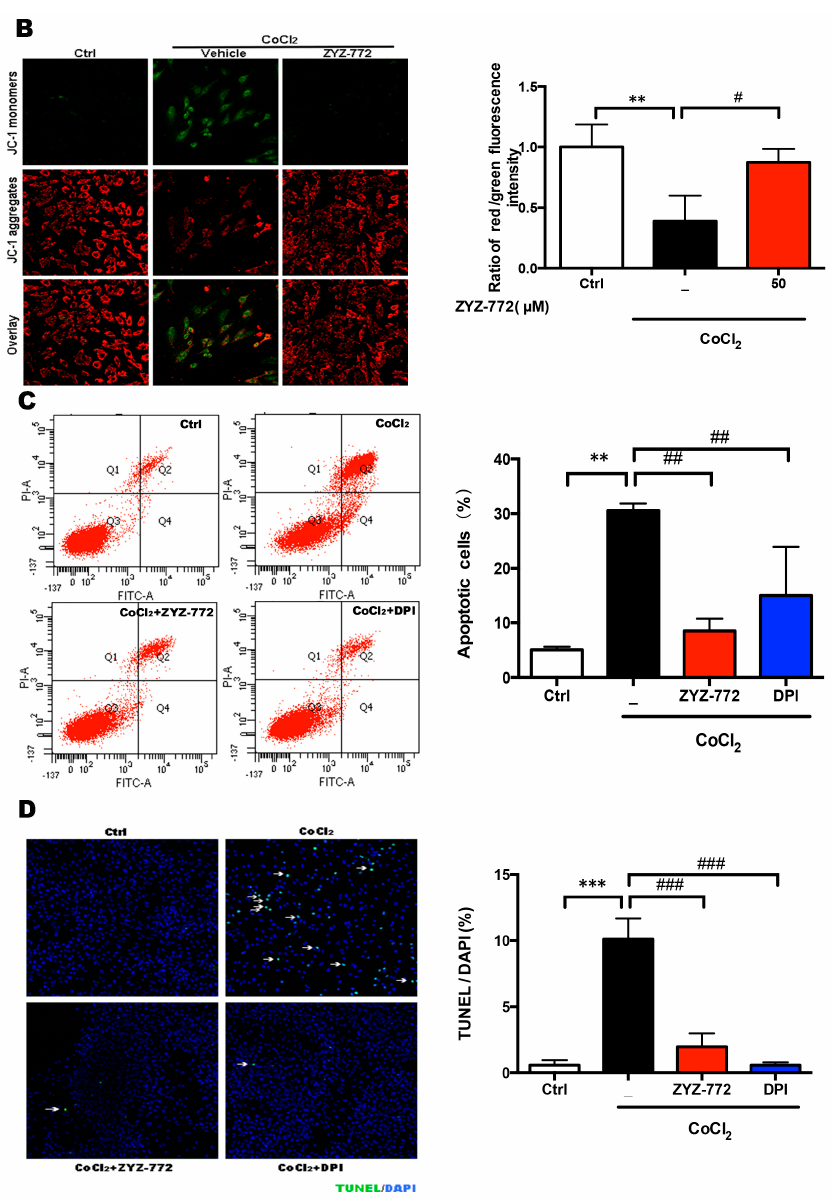
Figure 4. ZYZ-772 attenuates CoCl 2 induced apoptosis via P53 mediated mitochondrial apoptosis signaling. H9c2 cells were pretreated with 50 µ M ZYZ-772 or 10 µ M DPI for 2 h, then stimulated with 1 mM CoCl 2 for 12 h. ( A ) Gene expression of P53, Bax, Caspase-9 and Caspase-3 were measured by western blot analysis; ( B ) Representative image and quantitative analysis of JC-1 fluorescence staining for the changes in mitochondrial membrane potential ( ∆Ψ m); ( C ) Flow cytometry detection of ROS with DCFHA fluorescence probe; ( D ) Immunofluorescent staining detection of apoptotic nuclei using TUNEL assay. Values are presented as mean ± S.D., ** p < 0.01; *** p < 0.001 versus control group. # p < 0.05; ## p < 0.01; ### p < 0.001 versus vehicle group. Error bars represent the data obtained from the experiments repeated three times or more.